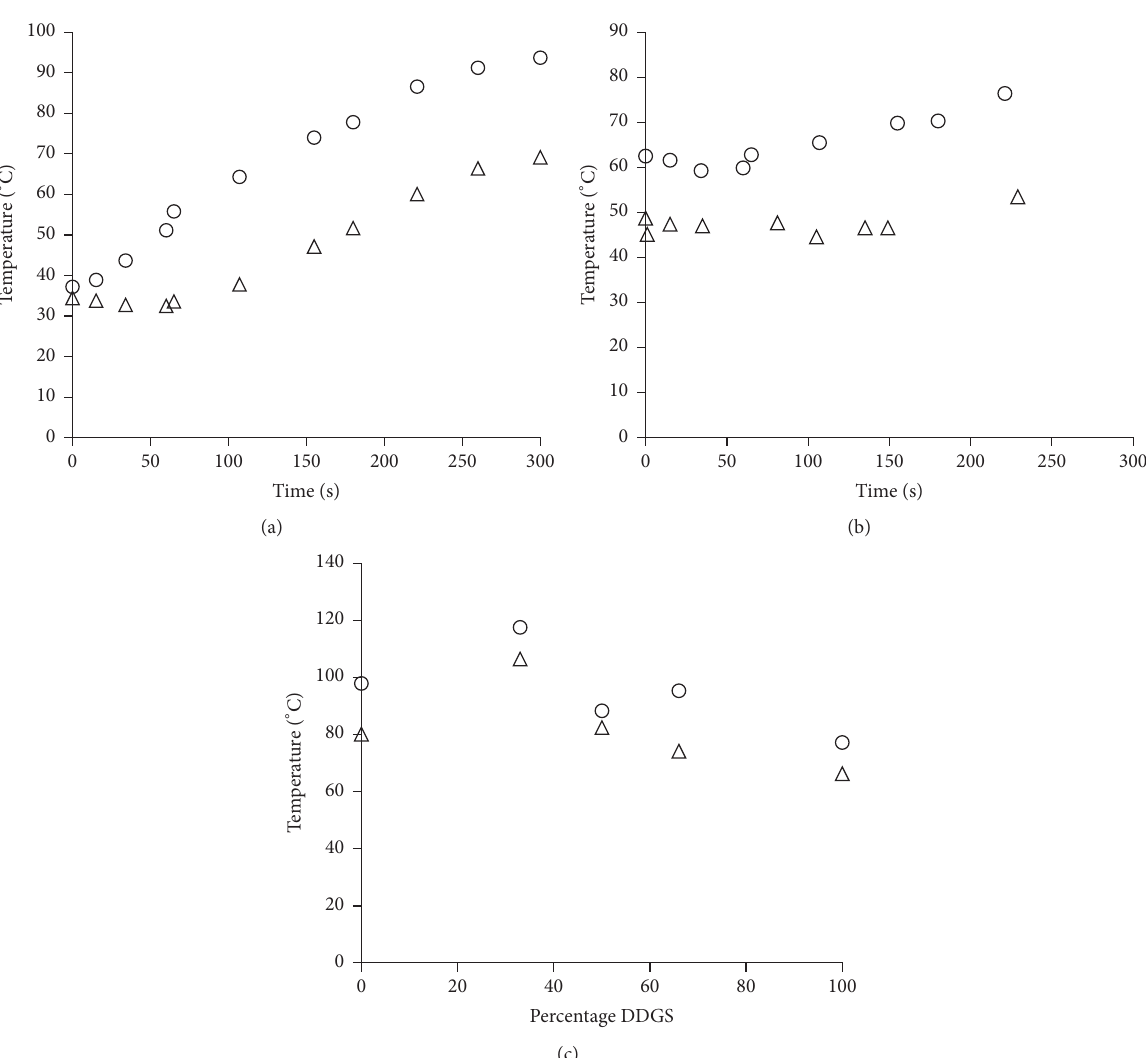
Figure 7: Temperature of zone 1 ( 𝑇 1 ) and zone 2 ( 𝑇 2 ) over time for extruding (a) CGM and (b) DDGS. (c) Maximum temperature during extrusion for blends. ( I : zone 1; 󳵻 : zone